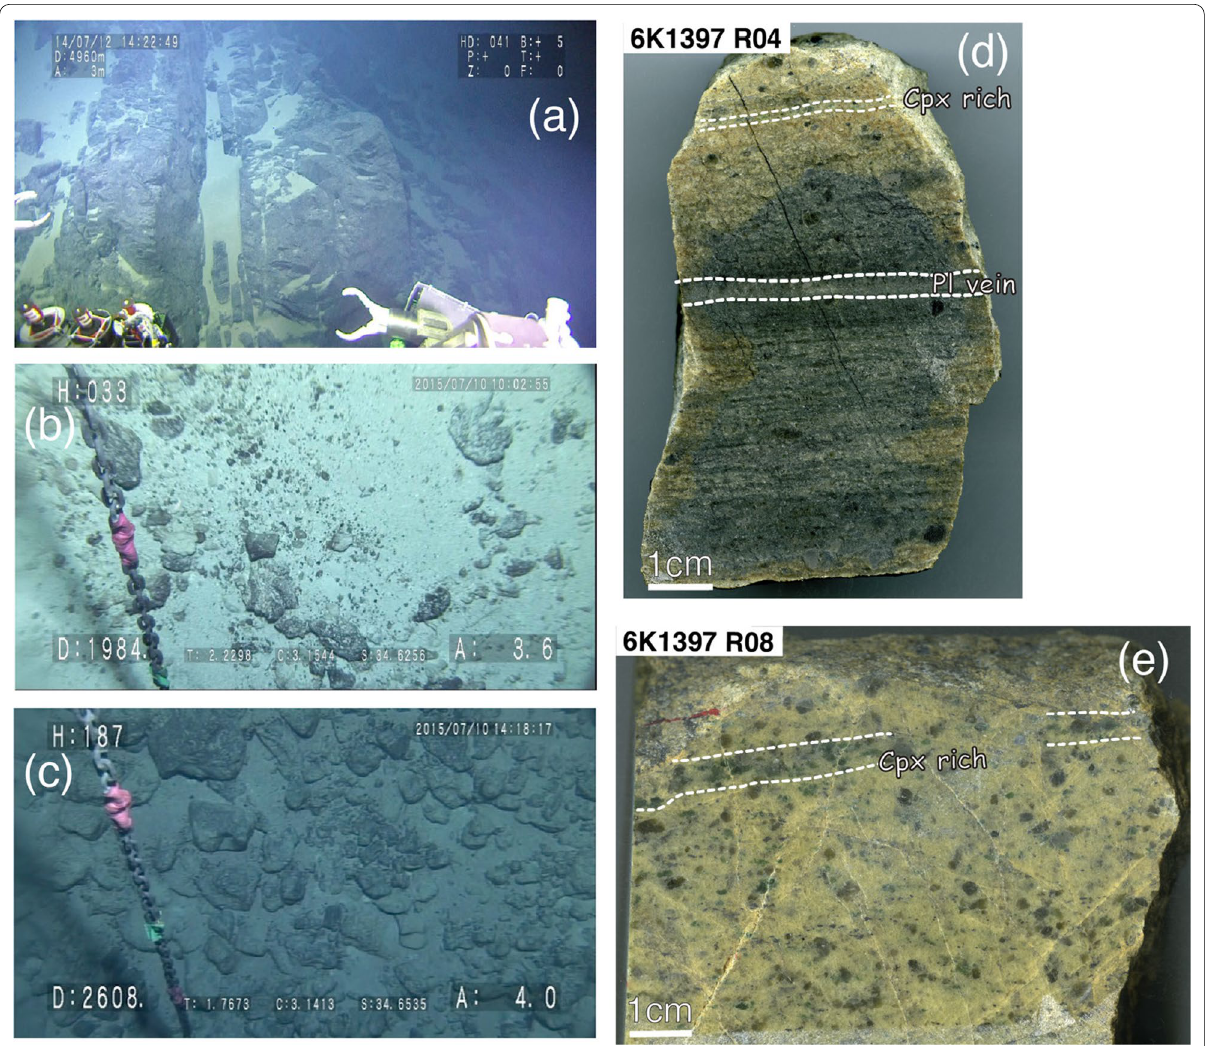
Fig. 2 a Peridotite outcrop on the southwestern slope of the 139°E Ridge (4960 mbsl; dive 6K1397). b Volcanic and carbonate gravels that cover the shallower part of the southwestern slope of the 139°E Ridge (1984 mbsl; YKDT‑170). c Mn‑coated volcanic rubble covering a small knoll on the northern flank of the 139°E Ridge (2608 mbsl; YKDT‑171). d Photograph of a saw‑cut surface of peridotite sample 6K1397‑R04. e Photograph of a saw‑cut surface of peridotite sample